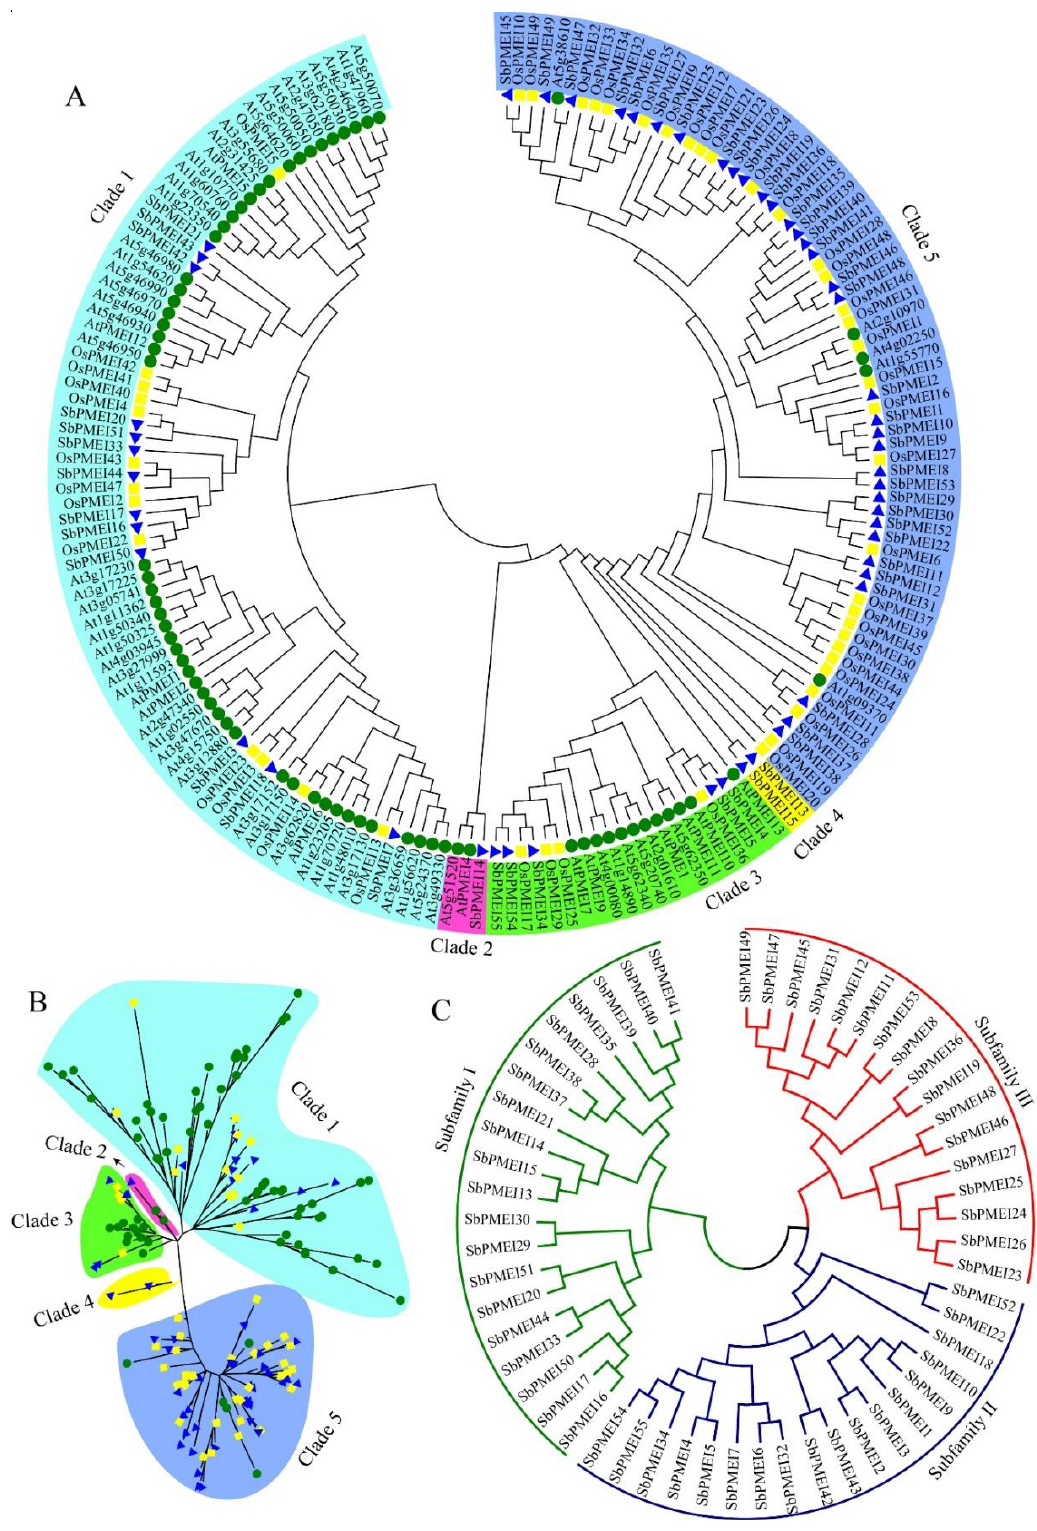
Figure 3. The phylogenetic tree analysis. ( A ) and ( B ) Maximum likelihood (ML) tree of PMEI proteins of Sorghum bicolor (blue triangle), Arabidopsis thaliana (green circle), and Oryza sativa (yellow square) fell into five clades. ( C ) Three subfamilies were evolved based on the neighbor-joining (NJ) tree of 55 S. bicolor PMEI proteins.